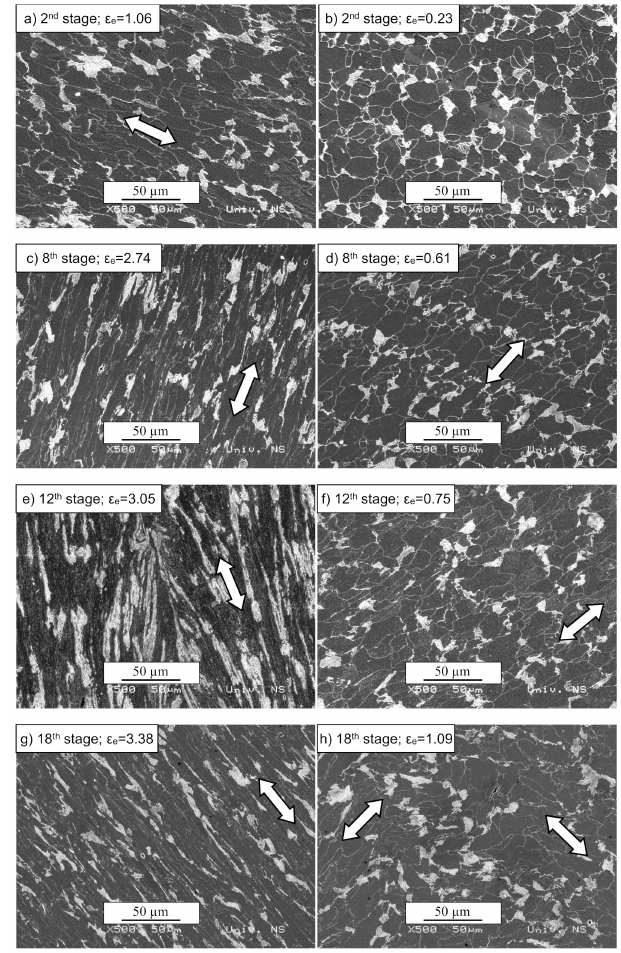
Figure 11. SEM microstructure after several stages of the process (500 × ). The images on the left correspond to axis c , and on the right to the contact surface vicinity. ( a ) 2nd stage, ε e = 1.06, ( b ) 2nd stage, ε e = 0.23, ( c ) 8th stage, ε e = 2.74, ( d ) 8th stage, ε e = 0.61, ( e ) 12th stage, ε e = 3.05, ( f ) 12th stage, ε e = 0.75, ( g ) 18th stage, ε e = 3.38, ( h ) 18th stage, ε e =